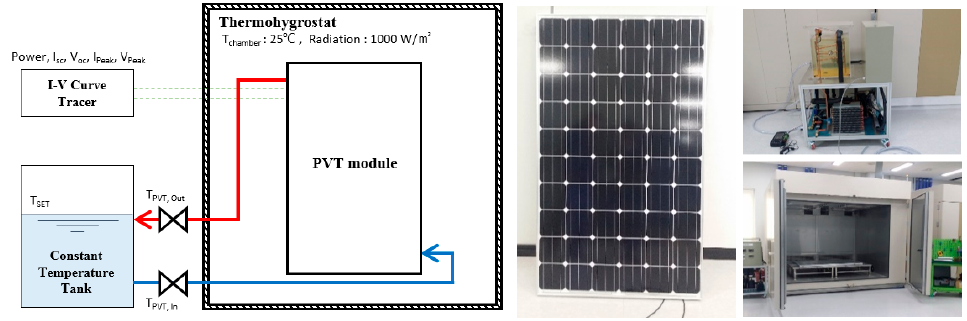
Figure 14. Scheme of the PVT performance experiment. Table 5. Experiment results of the PVT performance experiment [24].